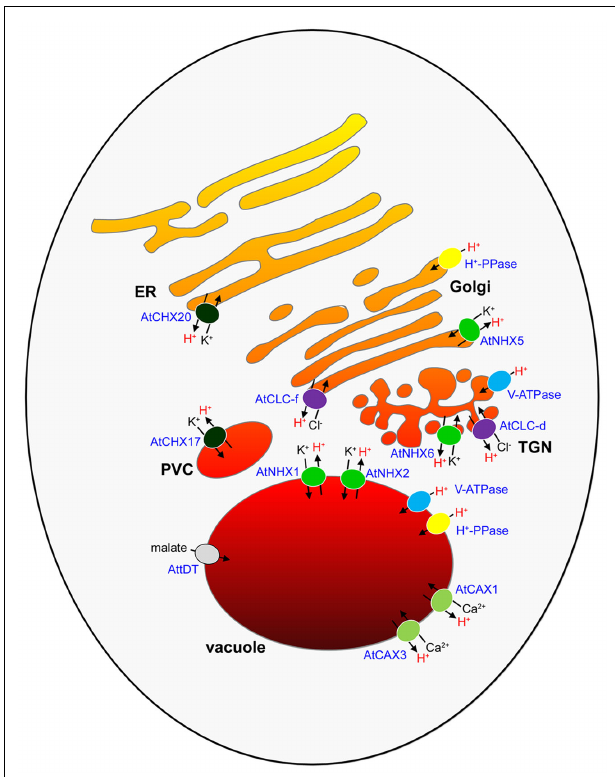
FIGURE 1 |The endomembrane compartments of a plant cell and their putative pH regulators. The different colors of the endomembrane compartments indicate different luminal pH values of organelles.The secretory compartments are proposed to increase in acidity from the ER (at near neutral pH) to the vacuole ( ∼ pH 5.5), as determined from measurements in secretory compartments of other eukaryotes.V-ATPase and H + -PPase H + pumps, K + /H + exchangers, Ca 2 + /H + exchangers, Cl − /H + exchangers, and a malate transporter that are involved or implicated in intracellular pH regulation in Arabidopsis are shown. ER,